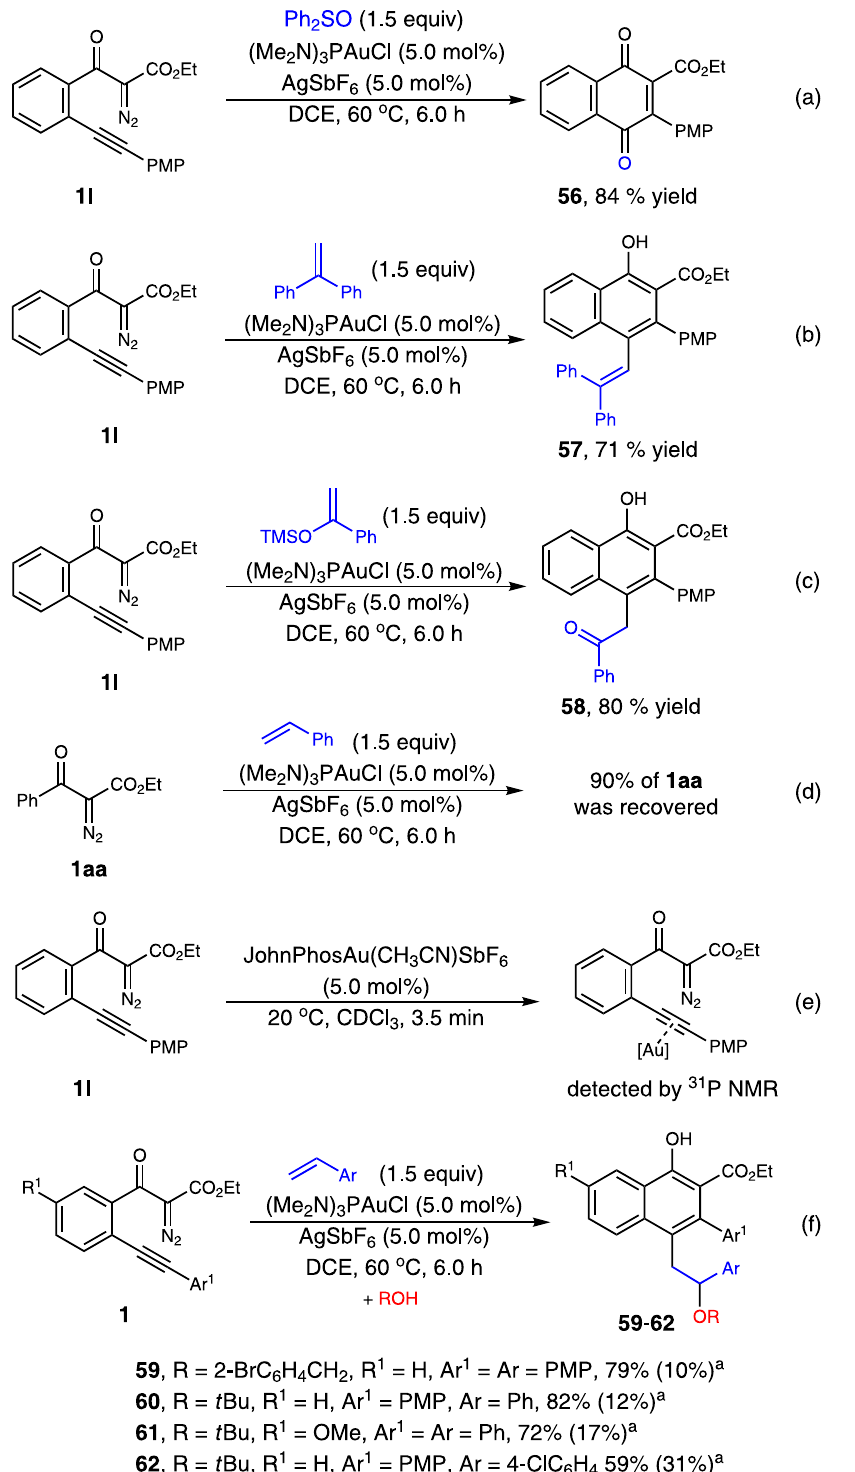
Fig. 6 Mechanistic experiments. a The data in parentheses are the yields of corresponding [4 + 2]-cycloadducts. a Control experiment with diphenyl sulfoxide. b Control experiment with 1,1-diphenylethylene. c Control experiment with 1-phenyl-1-trimethylsiloxyethylene. d Control experiment with 1,3- dicarbonyl diazo compound 1aa . e Control experiment in the absence of alkene. f Three-component reaction of diazo compounds with alkenes and